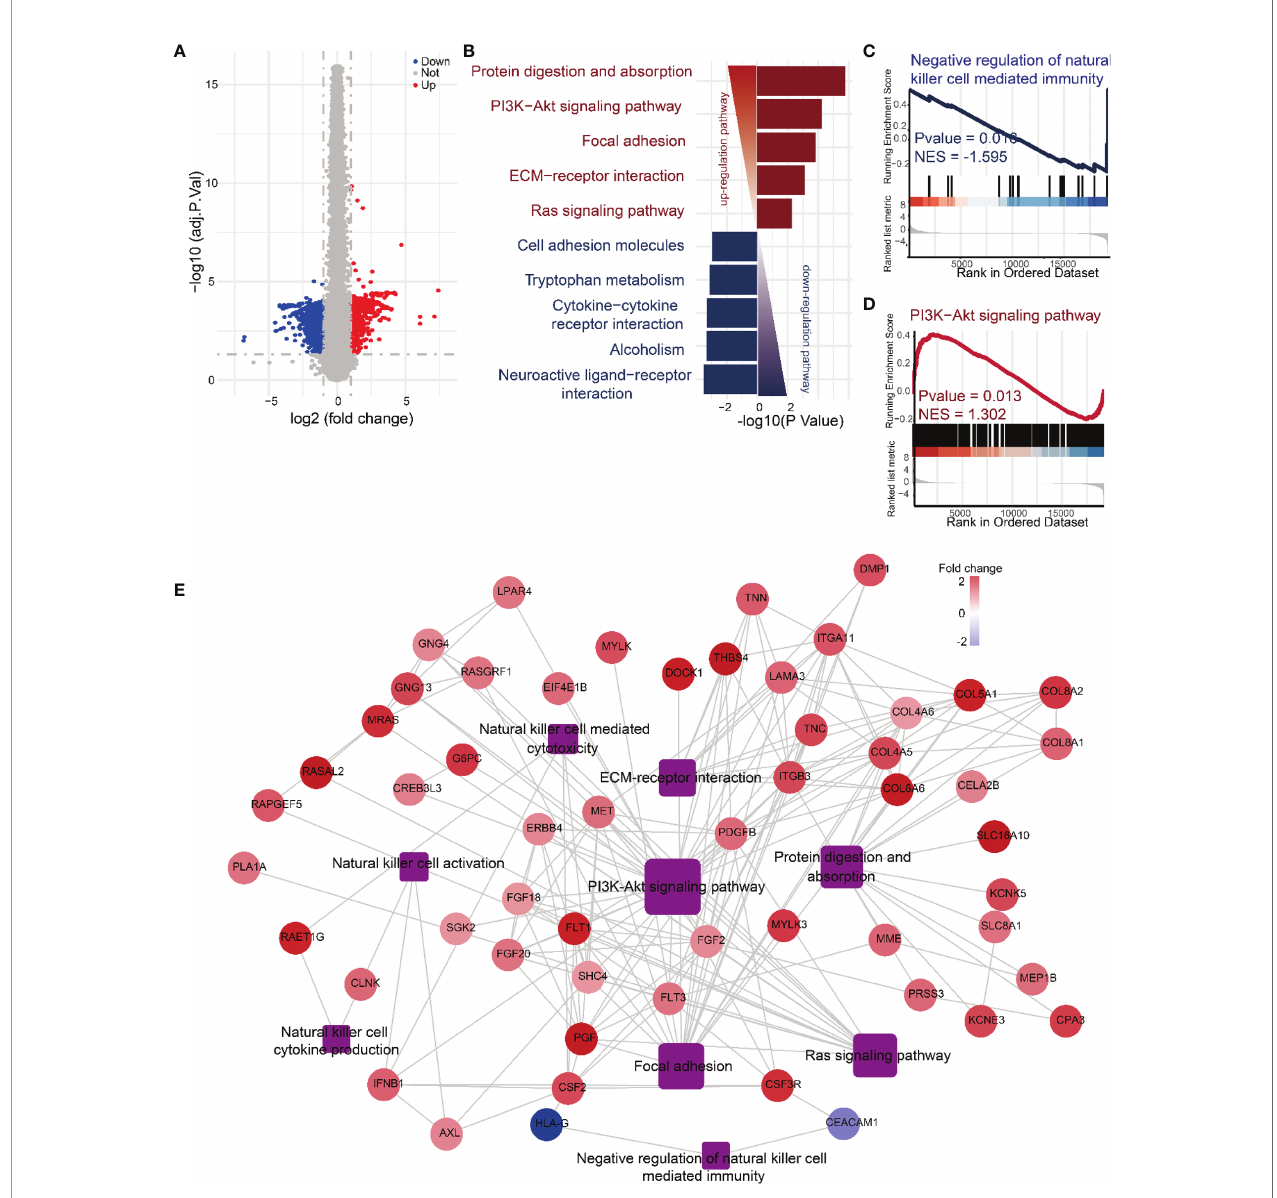
FIGURE 4 | Mechanisms of Daphnetin in regulating NK cell activation by RNA-sequencing analyses. Puri fi ed human primary NK cells were treated with DMSO or Daphnetin in the presence of IL-12 (10 ng/ml) for 12 h, followed by RNA-sequencing. (A) The volcano plot displayed differentially expressed genes in NK cells between IL-12 and IL-12 plus Daphnetin groups. (B) Top fi ve up- and downregulated KEGG pathways of the signi fi cant differently expressed genes (DEGs) on NK cells between IL-12 and IL-12 plus Daphnetin groups. Up- and downregulated KEGG pathways are shown in red and blue, respectively. (C, D) GSEA analysis of the negative regulation of natural killer cell-mediated immunity signaling pathway (C) and PI3K-Akt signaling pathway (D) between IL-12 and IL-12 plus Daphnetin groups. (E) PPI and gene-pathway network analyses of the genes from the top fi ve upregulated KEGG pathways and NK cell effector function-related DEGs. The ellipse and rectangle show the genes and the gene-related pathways, respectively. The color intensity in each node represents the fold change of the gene in Daphnetin to DMSO samples (upregulation of a gene is shown in red and downregulation of a gene is shown in blue). The size of the rectangle is proportional to the number of genes involved in the